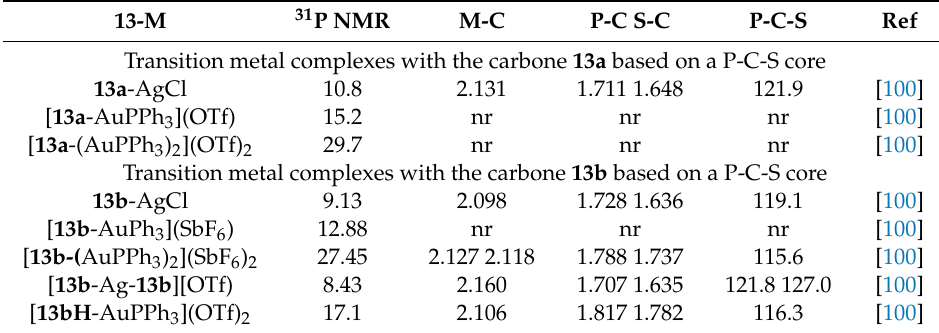
Figure 16. Carbone complexes reported by Fujii et al. [100].